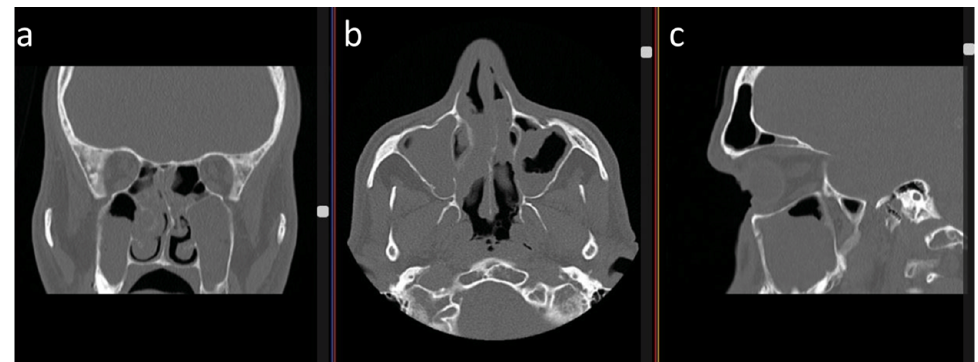
Figure 1. CT scan in three spatial planes in a patient suffering from CRS. ( a ) Coronal reconstruction with opacification of the maxillary sinus and the ethmoid sinus bilaterally on both sides. ( b ) Axial reconstruction; when viewed together with A, it can be observed that there is a subtotal obstruction in both maxillary sinuses due to secretion and mucosal swelling. ( c ) Sagittal reconstruction; the frontal sinus is largely unaffected. There is discrete residual ventilation in the cranial part of the maxillary sinus.